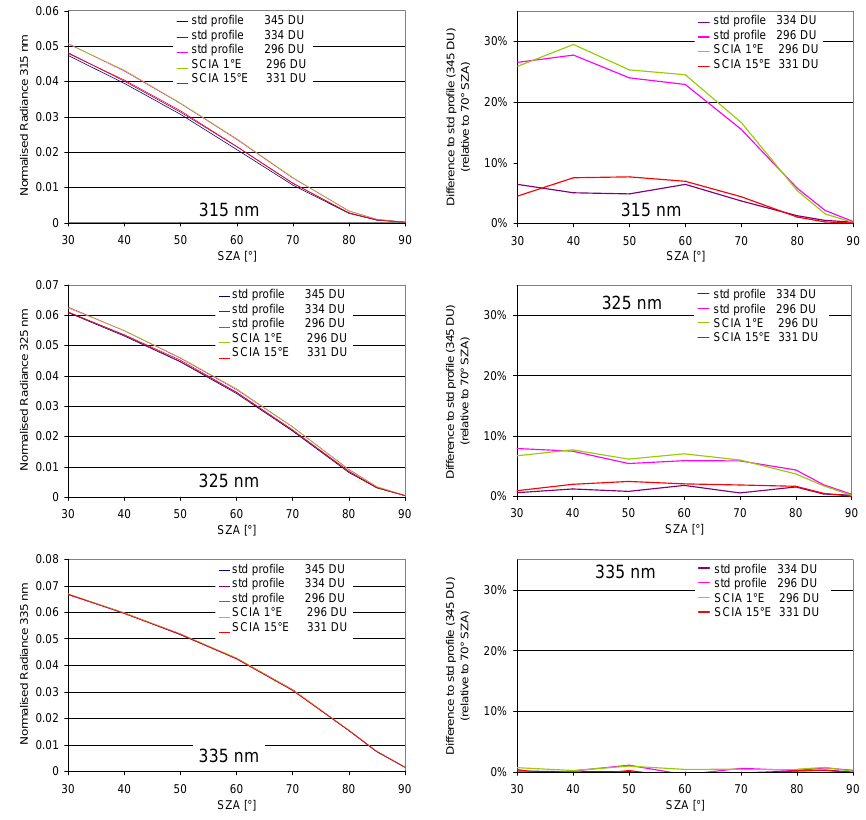
Figure A2. Left: simulated radiances for the different O 3 profiles shown in Fig. 3. The profiles differ in shape and O 3 VCD. Right: relative differences of the radiances compared to the standard profile (345DU) (the radiance differences are divided by the radiances at SZA = 70 ◦